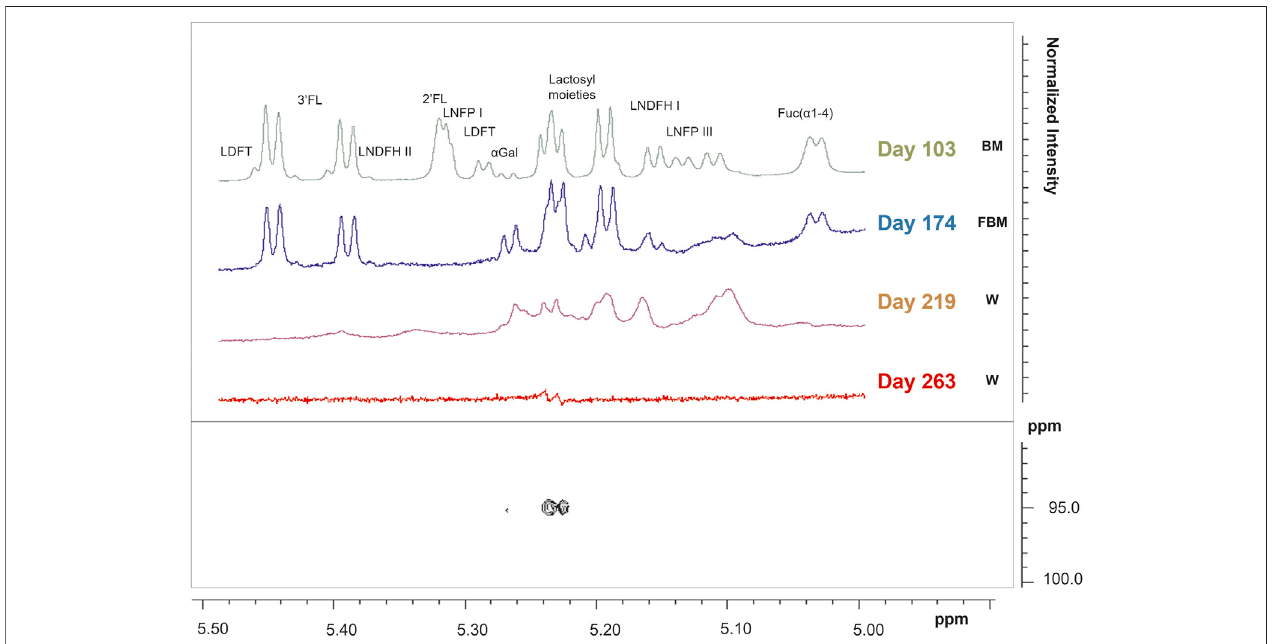
FIGURE 2 | 1 H NMR spectra of infant ’ s stool samples as focused on the human milk oligosaccharides (HMOs) anomeric region from 5 to 5.50 ppm. Spectra of samples collected at days 103, 174, 219, and 263 after birth were reported in the upper panel. A representative Heteronuclear Single Quantum Correlation (HSQC) experiment of a fecal sample collected at the last sampling point, corresponding to day 263, showed how the lactosyl resonance is the only left among the other HMOs resonances (lower panel).